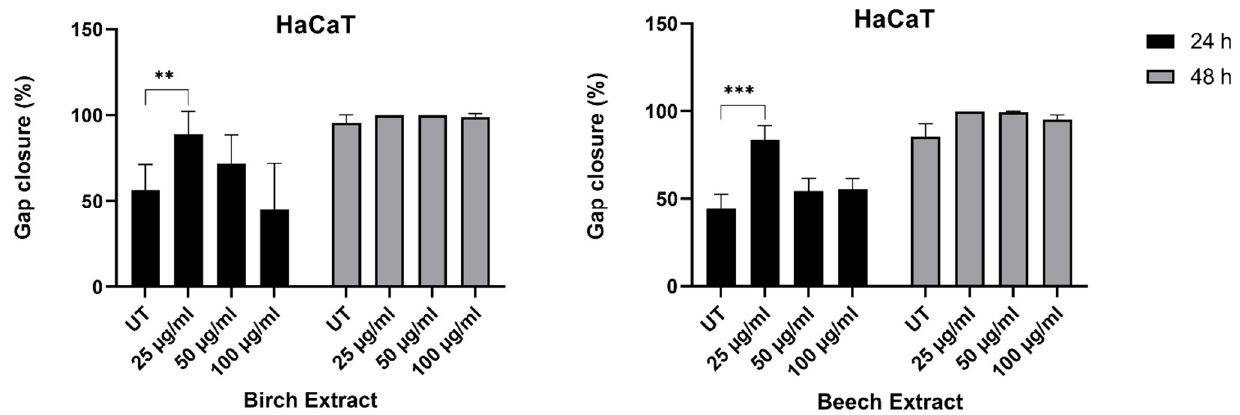
Figure 5. Wound-healing capacity of birch and beech extract reported as percentage gap closure at 24 and 48 h. The gap was defined as 0% closed at the beginning of the experiment. A fully closed gap resulted in 100% closure. N = 4, error bars present SD. Statistical significance: ** p < 0.01, *** p < 0.001.